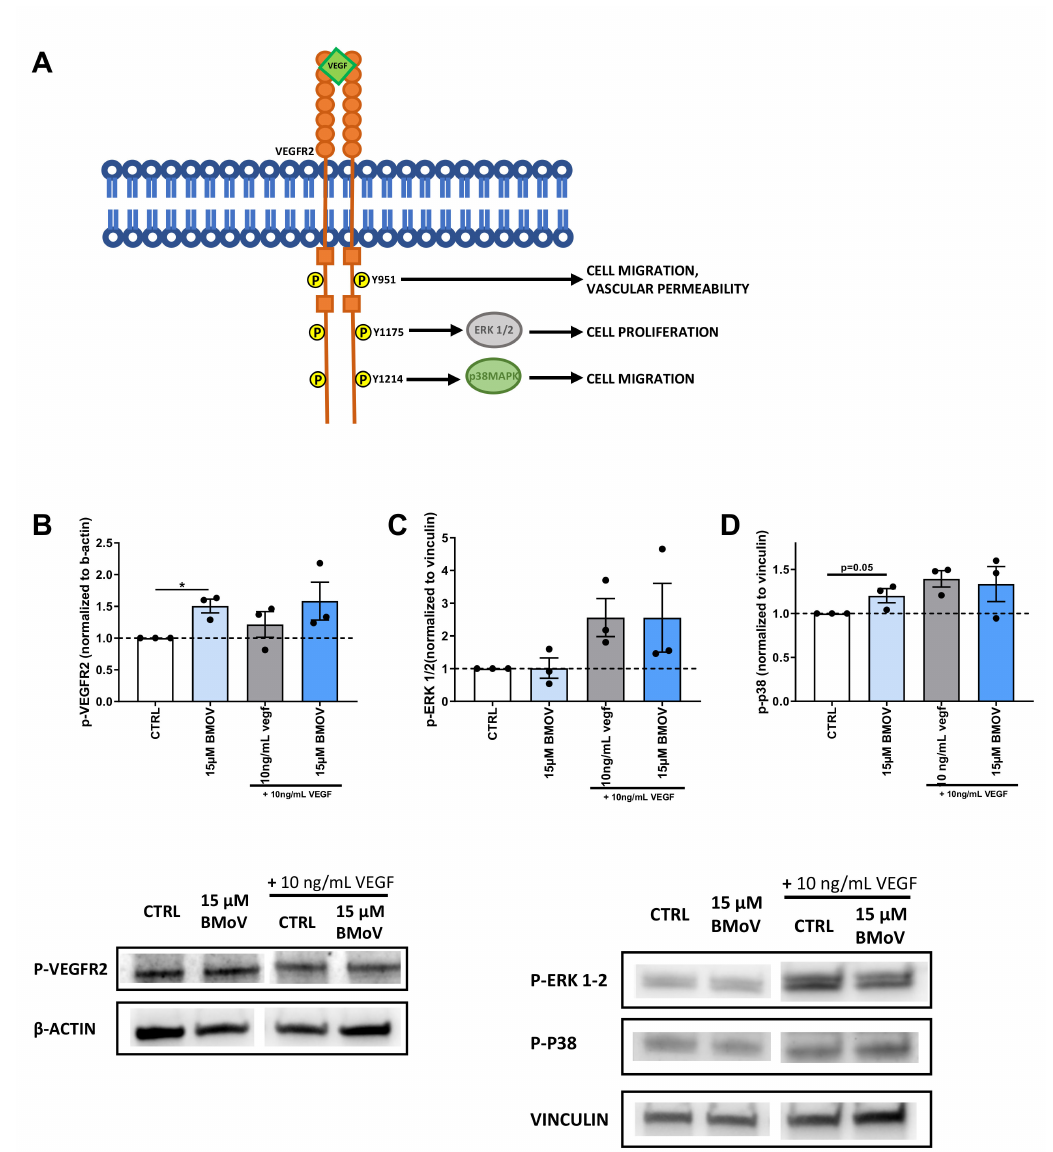
Figure 8. ( A ) Schematic representation of VEGFR2 signaling and downstream enzyme’s activation. ( B ) Relative p-VEGFR2, protein expression in HUVECs whole-cell lysates after treatment with indicated conditions as determined by western blot. Expression was normalized per independent experiment to stable household protein β -actin and expressed relative to CTRL. Relative ( C) p-ERK1 / 2 and ( D ) p-p38, protein expression in HUVECs whole-cell lysates after treatment with indicated conditions as determined by western blot. Expression was normalized per independent experiment to stable household protein vinculin and expressed relative to CTRL. (E) Quantification of the concentration of VEGF-A concentration in the cell culture medium of HUVECs incubated with the indicated conditions. All data points represent normalized averages obtained from 3 independent experiments and are presented as mean ± SEM. * p < 0.05; by one-sample t test versus CTRL or two-sided Student’s t test to compare CTRL versus BMOV